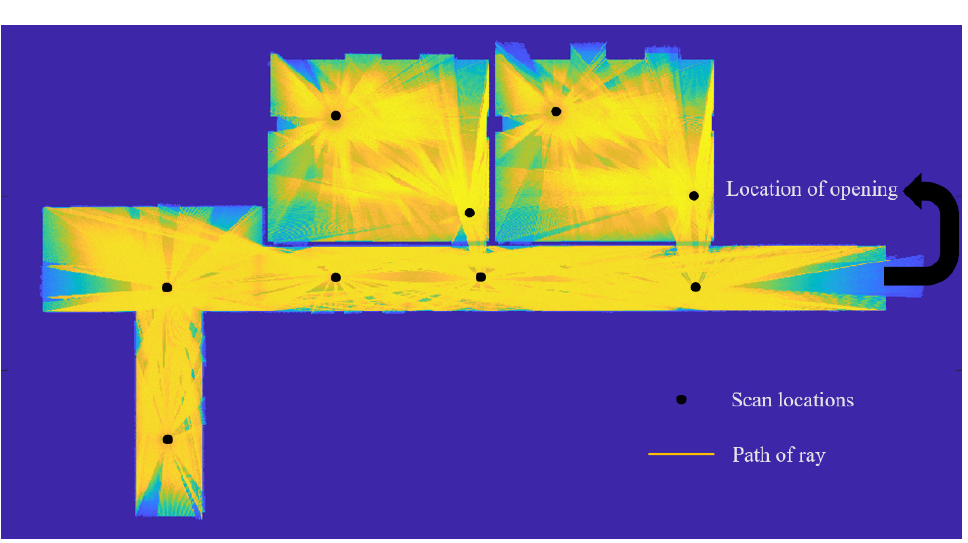
ner locations, and the yellow lines represent the ray paths.